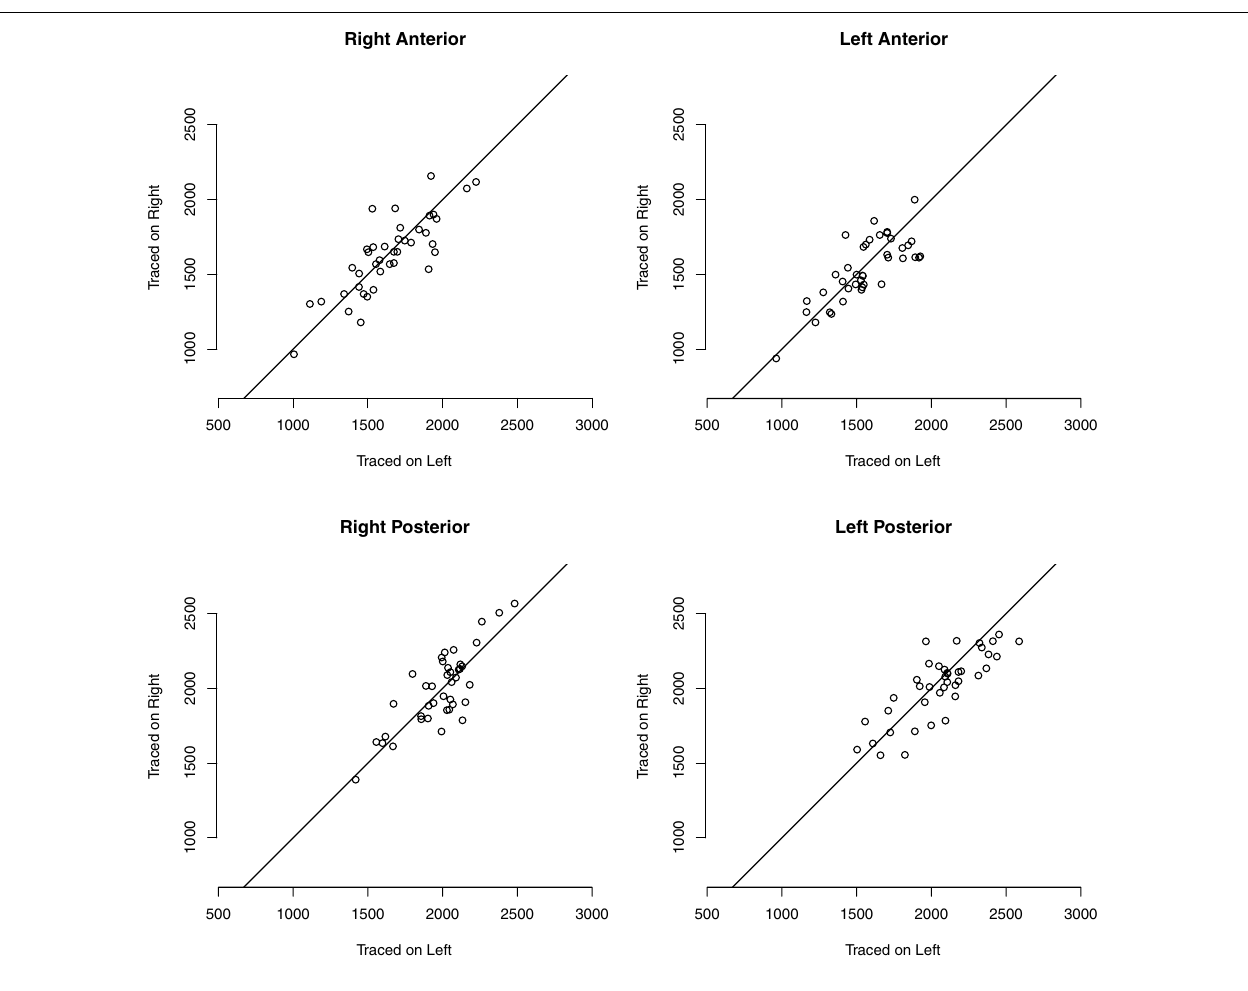
the image in coronal section, versus when presented on the left. Systematic error would appear as a shift away from the unity line. Statistical analysis in Section